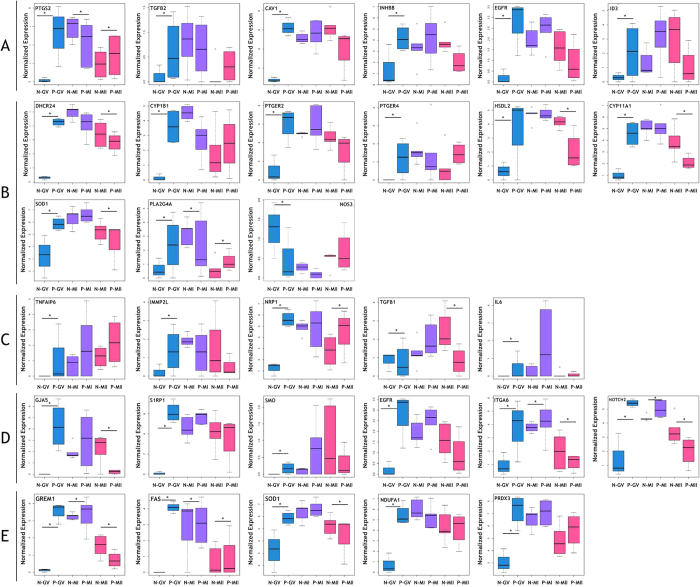
Differentially expressed genes in PCOS CCs studied through single-cell RNA sequencing.The threshold of Padj was set at < 0.05 to find significantly expressed genes. (A) Boxplot showing differentially expressed genes involved in CCs expansion. (B) Boxplot showing differentially expressed genes related to hormone receptor signaling. (C) Boxplot showing differentially expressed genes included in folliculogenesis. (D) Boxplot showing differentially expressed genes involved in gap junction. (E) Boxplot showing significantly expressed genes related to oxidative stress and genes predicting quality of oocyte. *Padj < 0.05. The y axis indicates the log2 (FPKM + 1) expression levels.